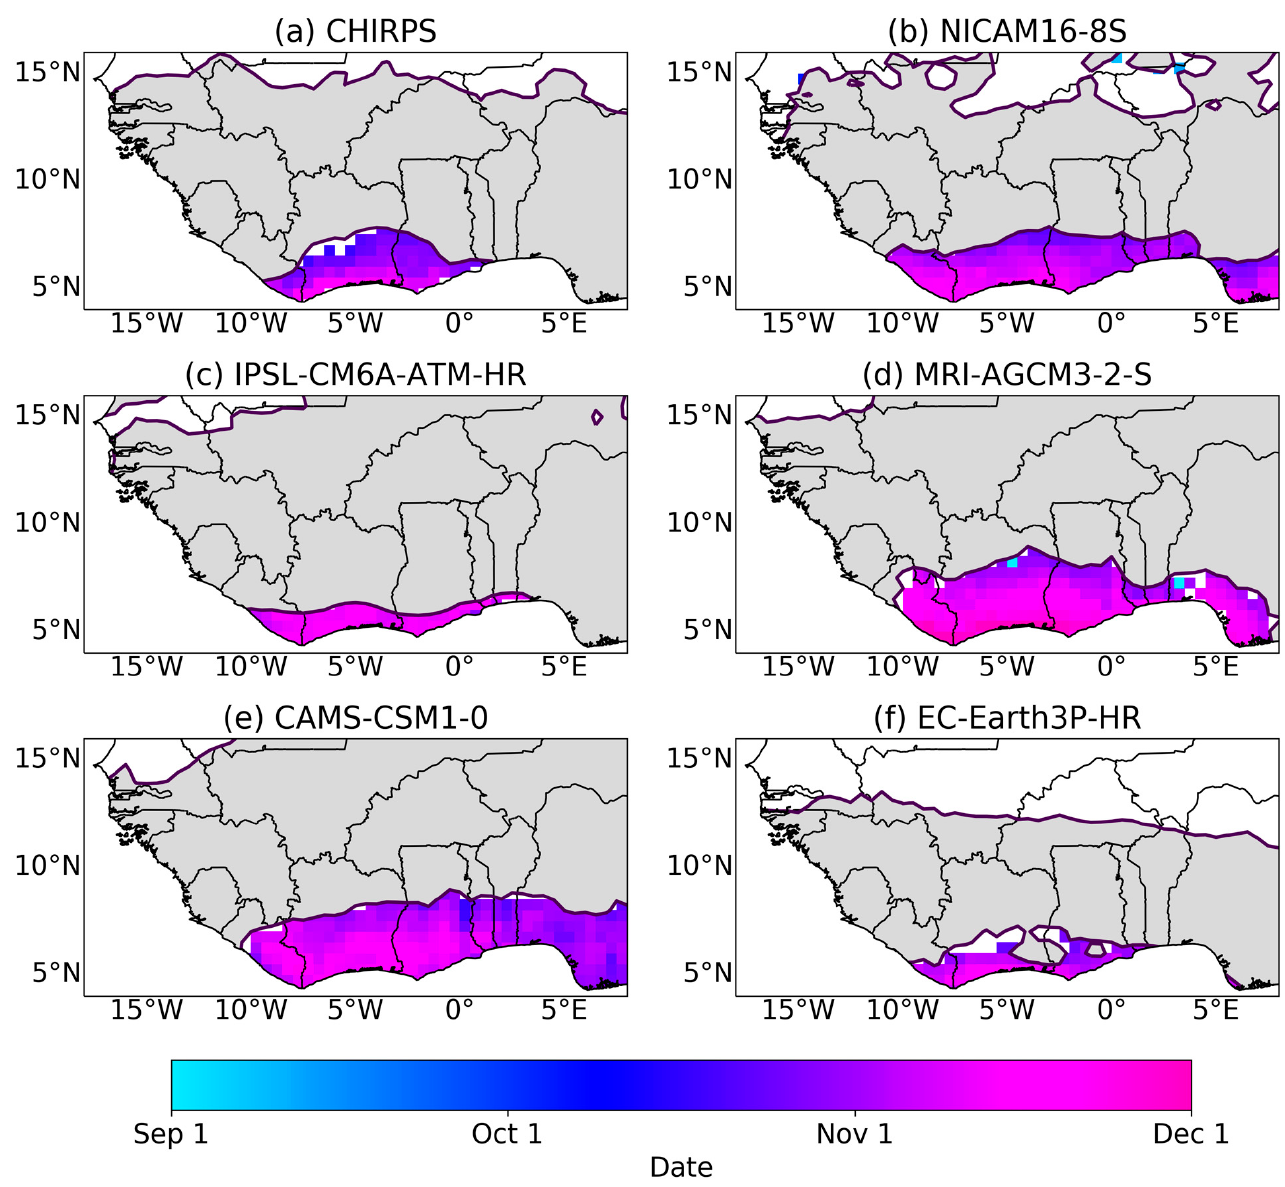
Figure 8. Mean cessation date for second (minor) rains for all data sets. Dark grey indicates annual regimes and white indicates dry regions.